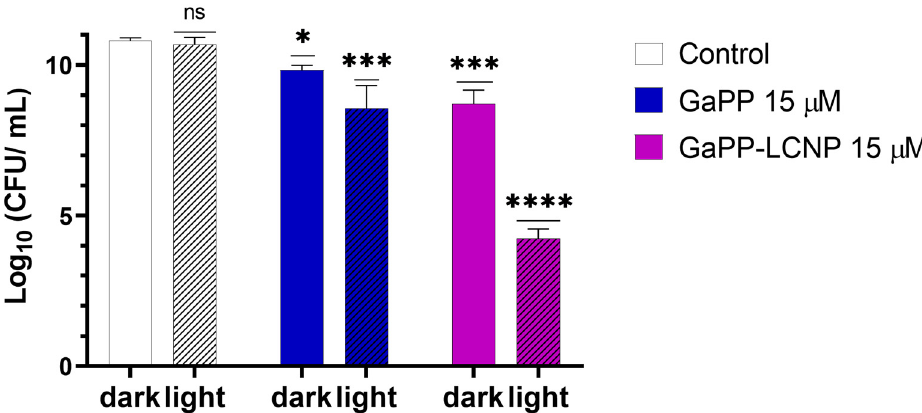
Figure 6. The viability of S. aureus (Xen29) biofilms following treatment with unformulated GaPP (15 µM) and GaPP-LCNP (15 µM), with and without blue light activation, energy fluence 32 J/cm 2 . Data plotted as mean ± SD, n = 3. ns: non-significant, * Significant reduction in viability p = 0.04, *** p = 0.0002, **** p < 0.0001 (two-way ANOVA test followed by multiple comparison Tukey’s test).